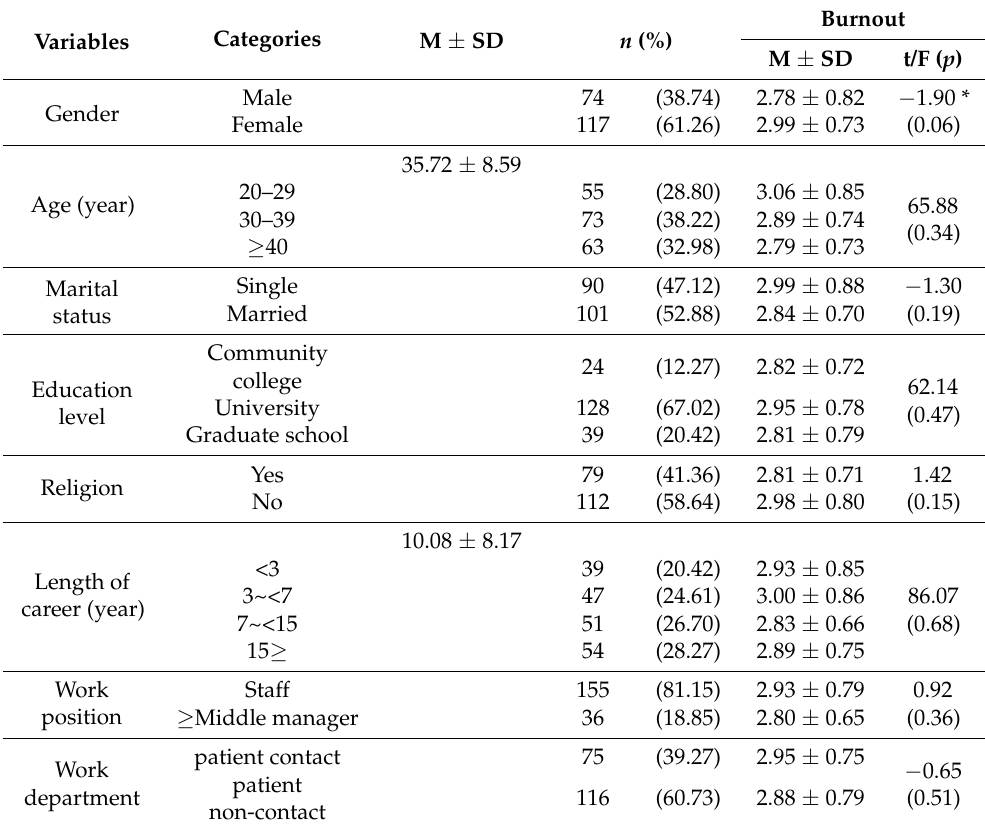
Table 1. Differences in burnout by general characteristics ( N =